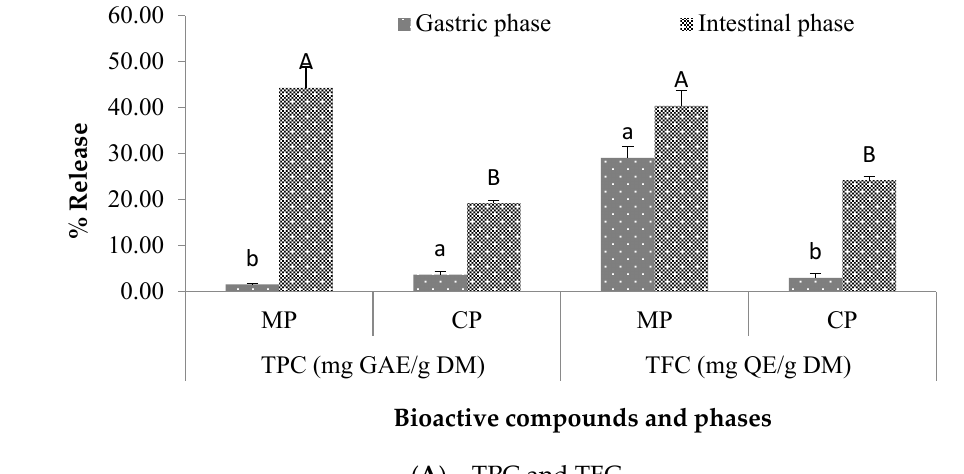
( C )—Antioxidant power